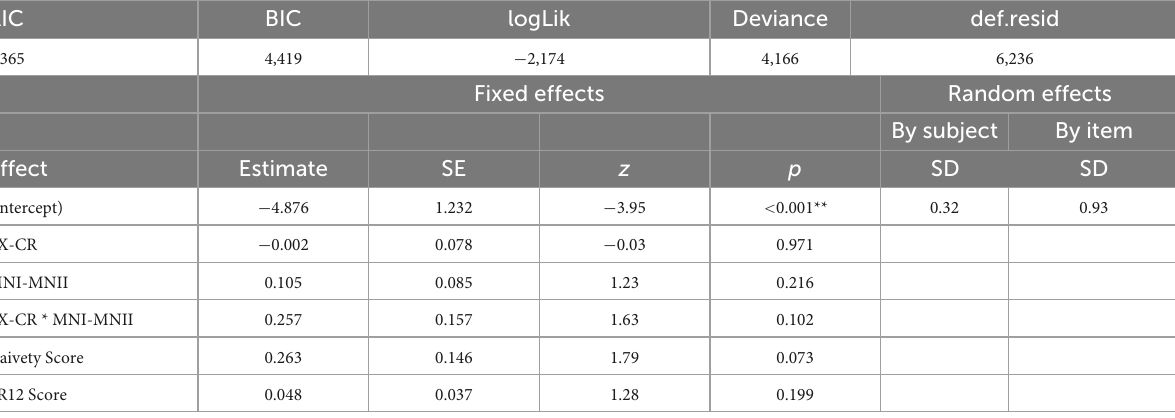
TABLE 9 Generalized linear mixed model for RR score in Experiment 2.